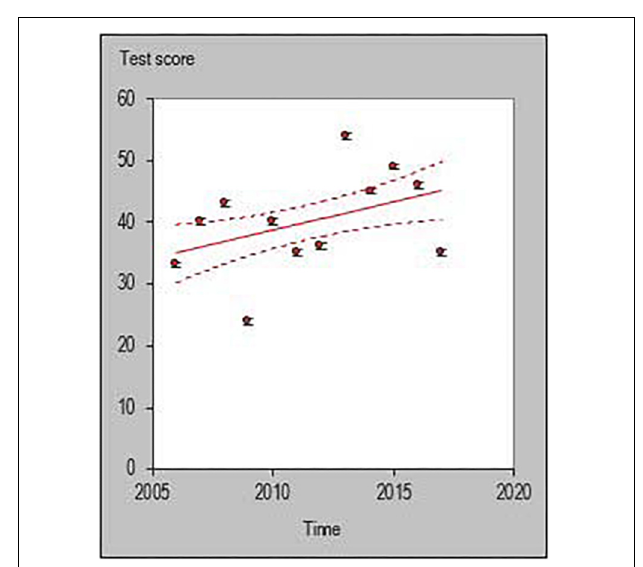
FIGURE 1 | Individual trend of one participant for average points per season normalized by minute.